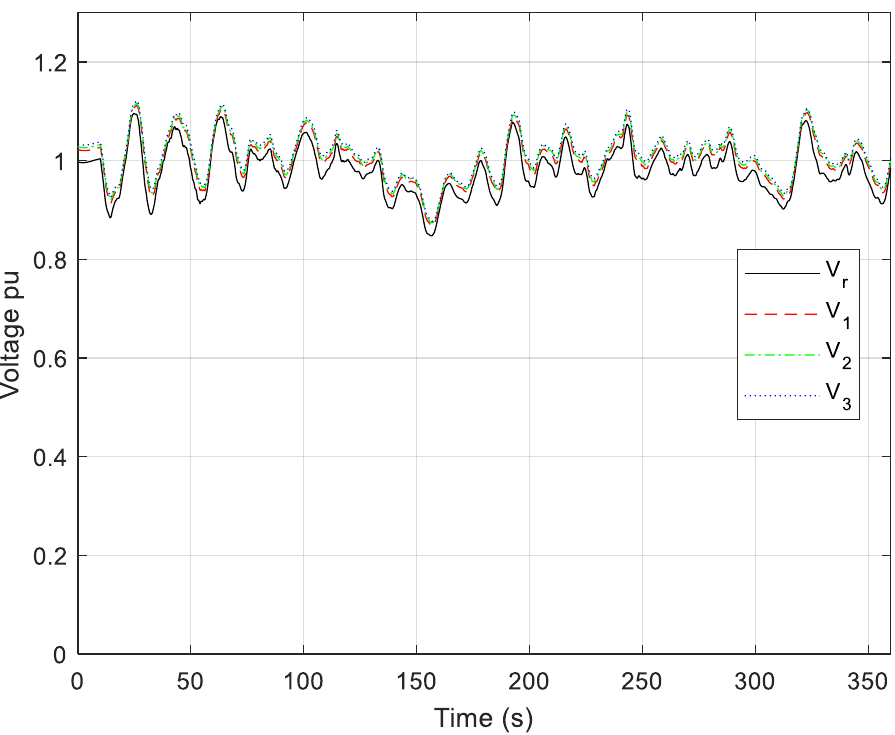
Figure 24. Regulated voltage V r and voltages V 1 – V 3 of PMSGs (random wind disturbance).